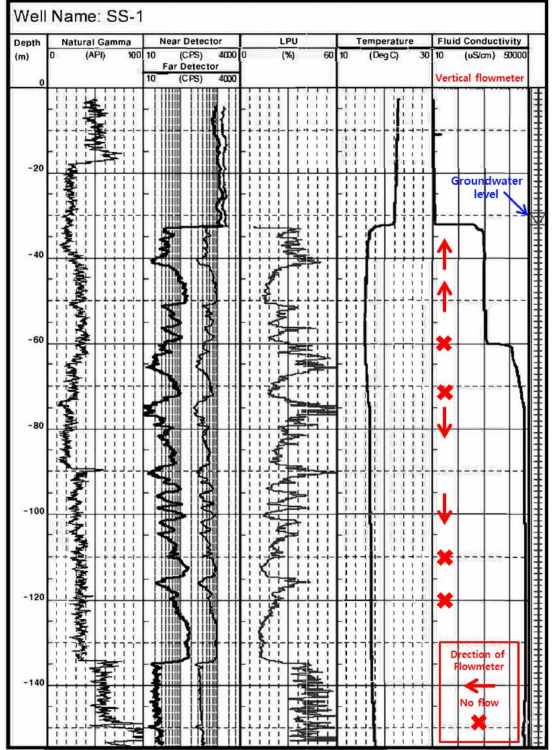
Figure 6. Results of the geophysical well logs from well SS-1 (from KIGAM (2004) report